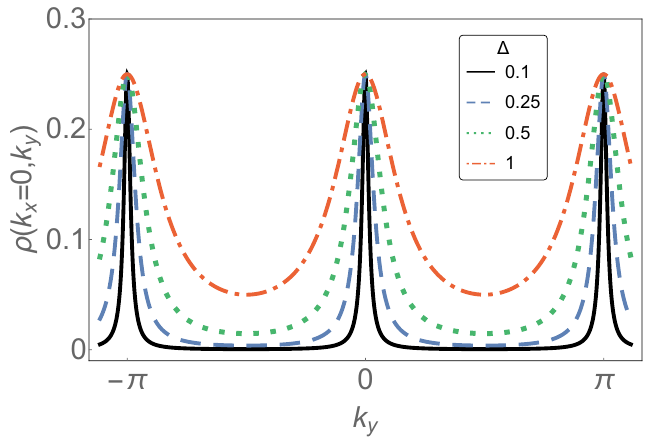
= 0, k ) obtained from x y